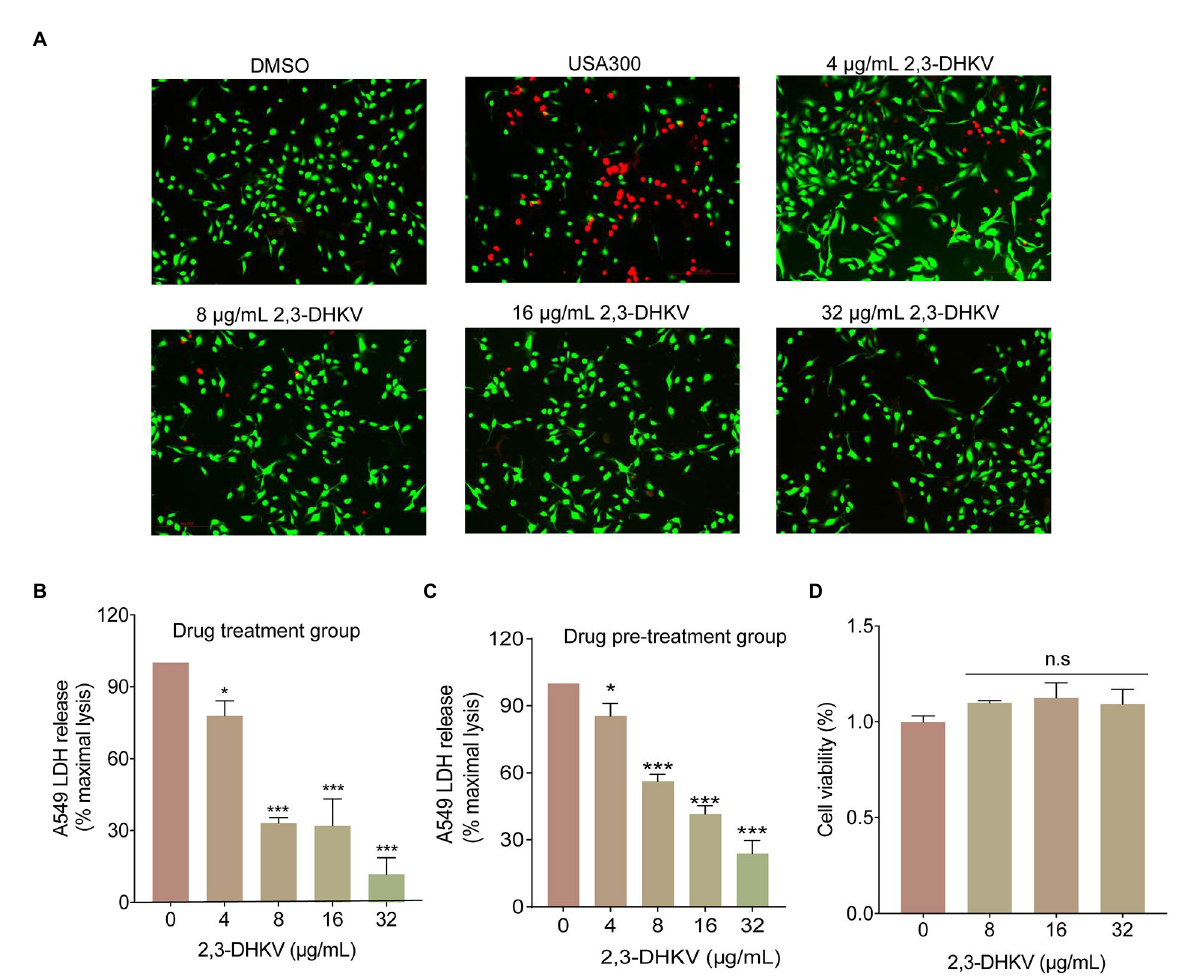
FIGURE 4 2,3-DHKV protects A549 cells from infection-induced damage. (A) A549 cells were infected with USA300 and treated with 2, 3-DHKV for live (green)/dead (red) cell staining assay. The LDH release was applied to evaluate the cytotoxicity of various concentrations of 2, 3-DHKV to supernatant of S. aureus USA300 infected A549 cells. (B) 2, 3-DHKV with S. aureus simultaneous addition group (Drug treatment group) (C) 2, 3-DHKV with S. aureus mixed culture group (Drug pre-treatment group). (D) MTT assay was used to assess the effect of 2,3-DHKV on the viability of A549 cells. * p < 0.05, *** p <